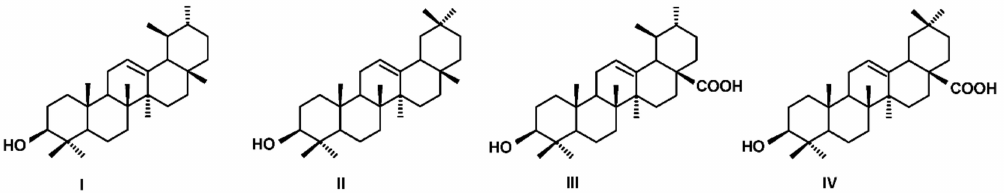
Figure 3. The structures of the triterpenoids identified in T. × media hairy roots. I, α -amyrin; II, β -amyrin; III, ursolic acid; IV, oleanolic